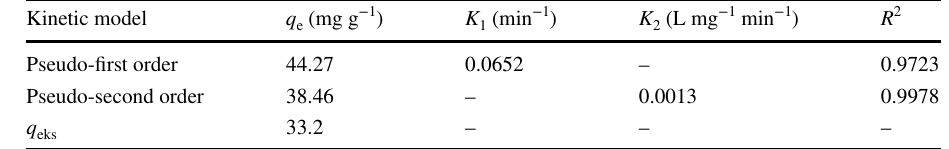
Table 4 Regression parameters for the kinetic models C